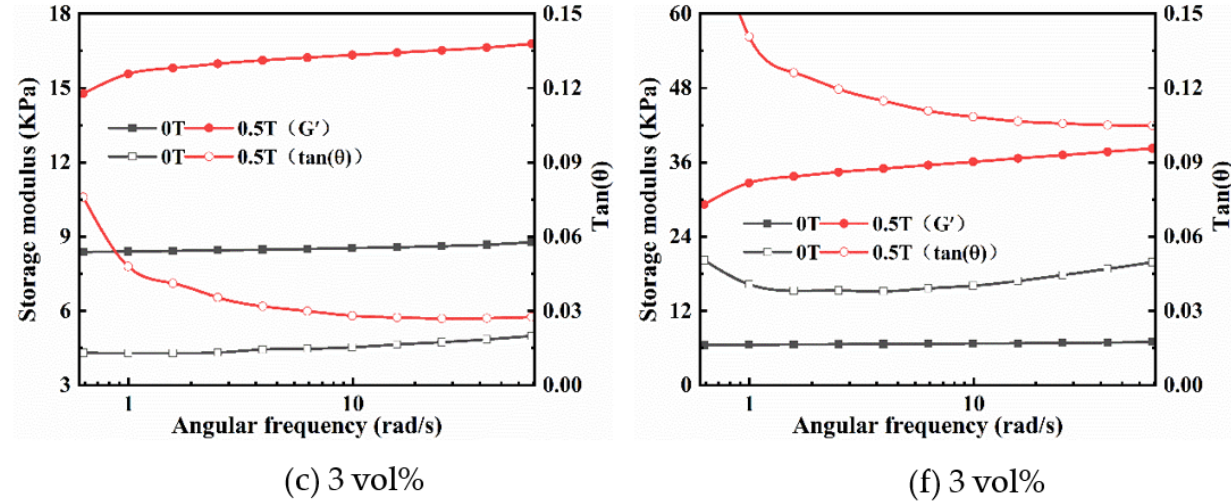
Figure 7. Angular frequency dependence of the G’ and tan δ of isotropy ( a – c ) and anisotropy ( d – f ) samples with CI of 1 vol%, 2 vol% and 3 vol% under 0 T and 0.5 T at a fixed strain amplitude of 0.1 %.